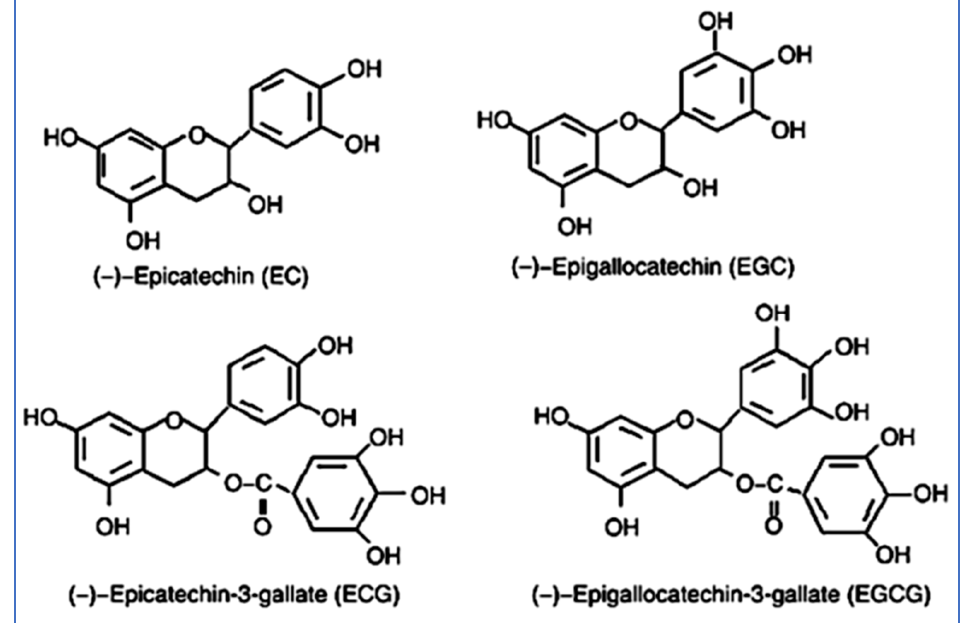
Figure 3. Different types of catechins.